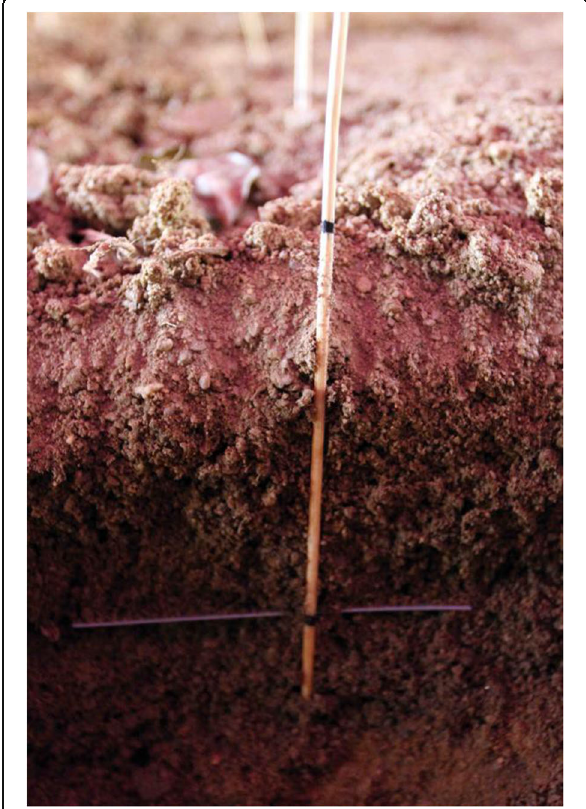
Fig. 14 Metal plate was excavated by digging from the side as indicated by the